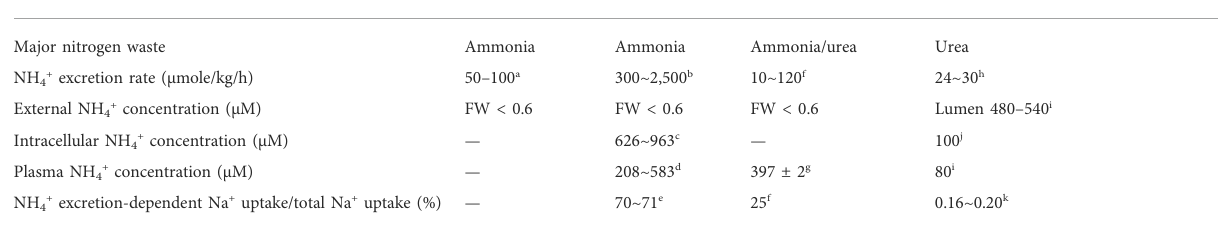
TABLE 1 Physiological parameters related to ammonia metabolism in different